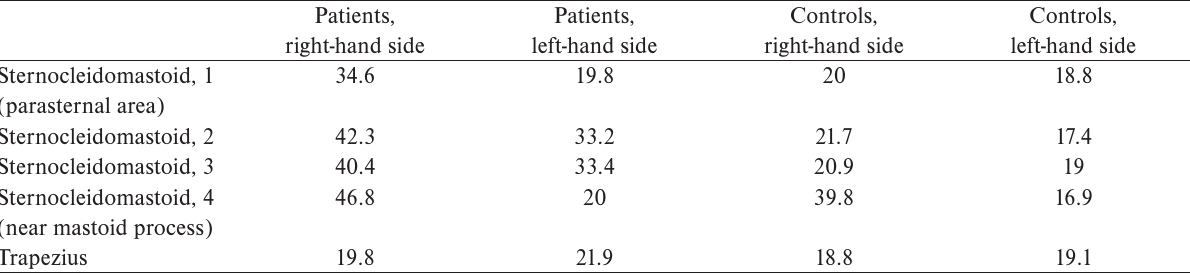
Controls, right-hand side